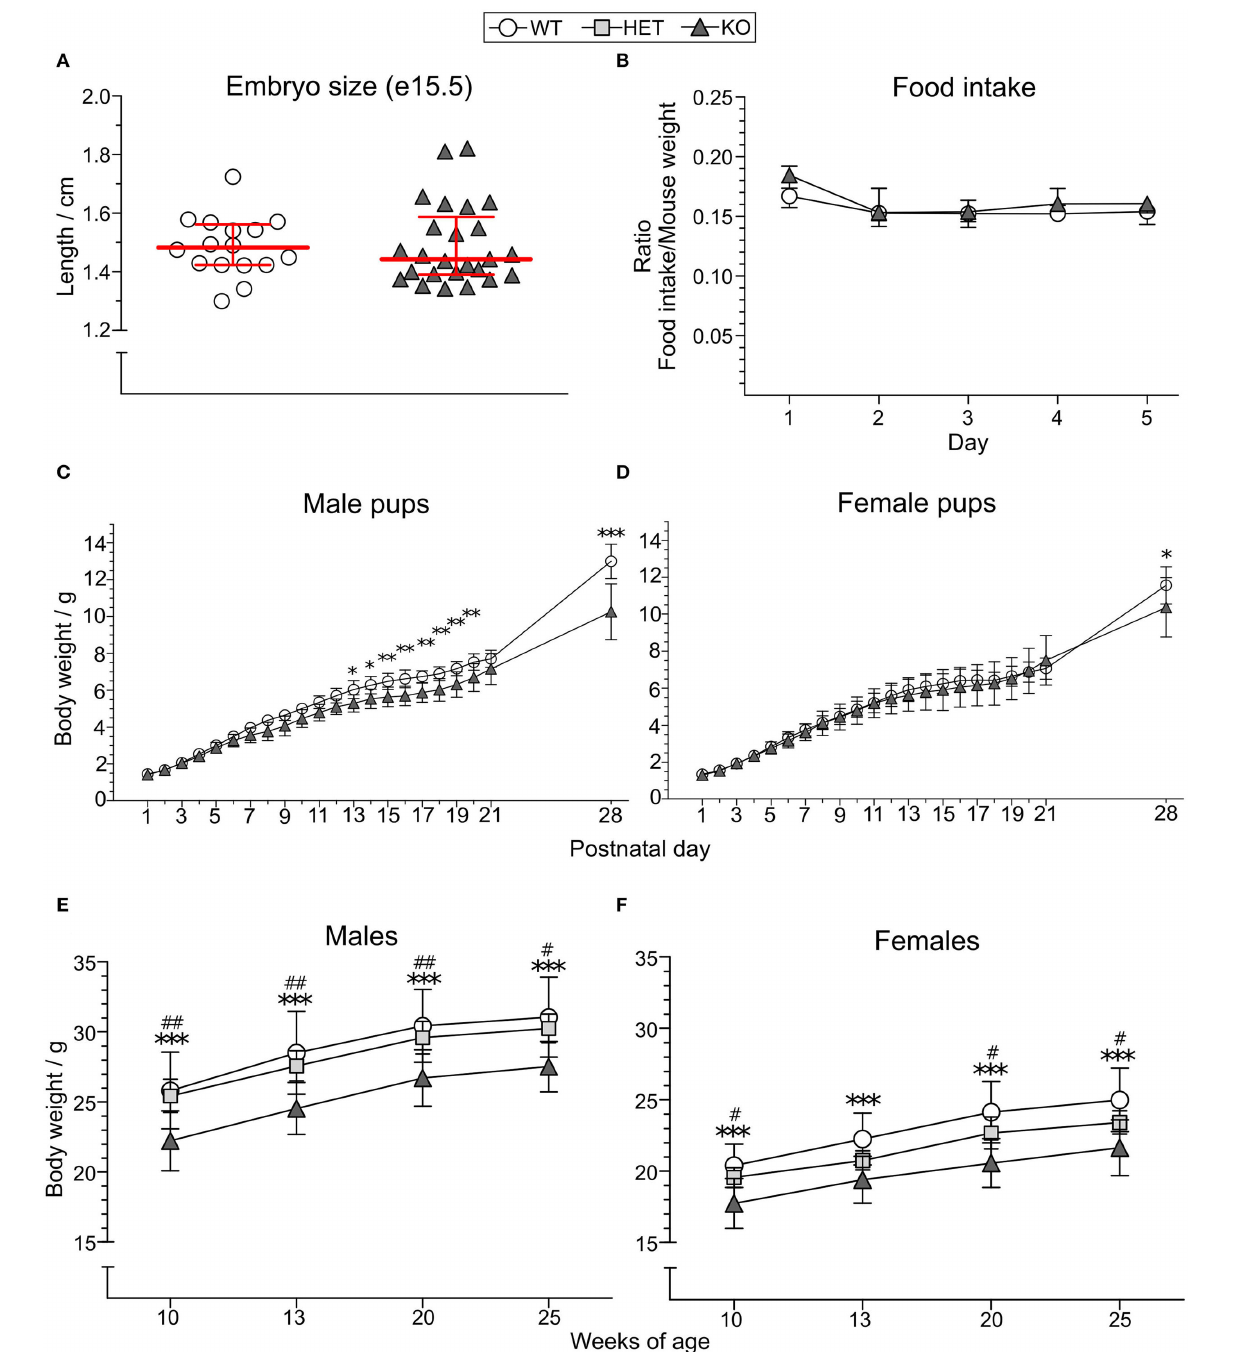
Frontiers in Behavioral Neuroscience |